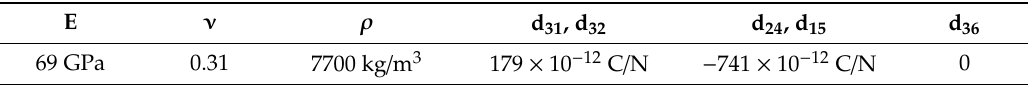
Table 2. Material properties of the piezoelectric sensors and actuator.